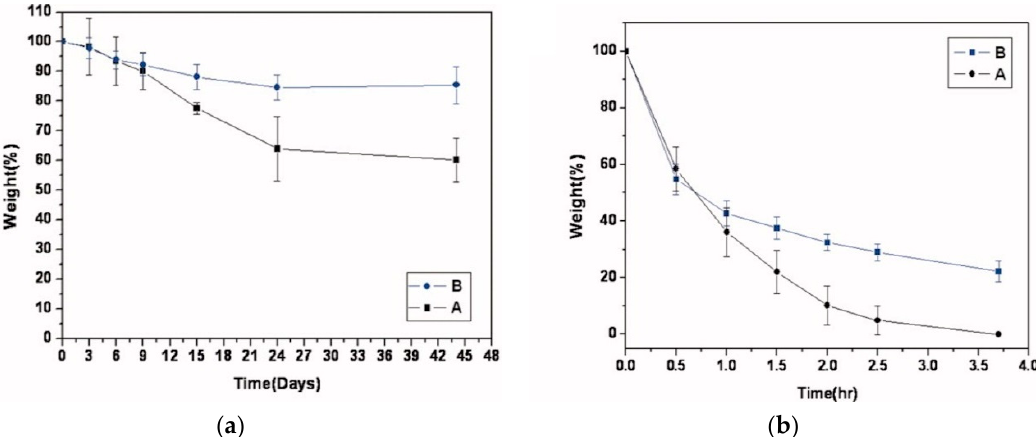
Figure 22. In vitro degradation rate of HA hydrogels: ( a ) degradation by hydrolysis, and ( b ) degradation by hyaluronidase. A: 10 kDa, B: 50 kDa. Reproduced from [132], with permission from John Wiley and Sons, 2020.